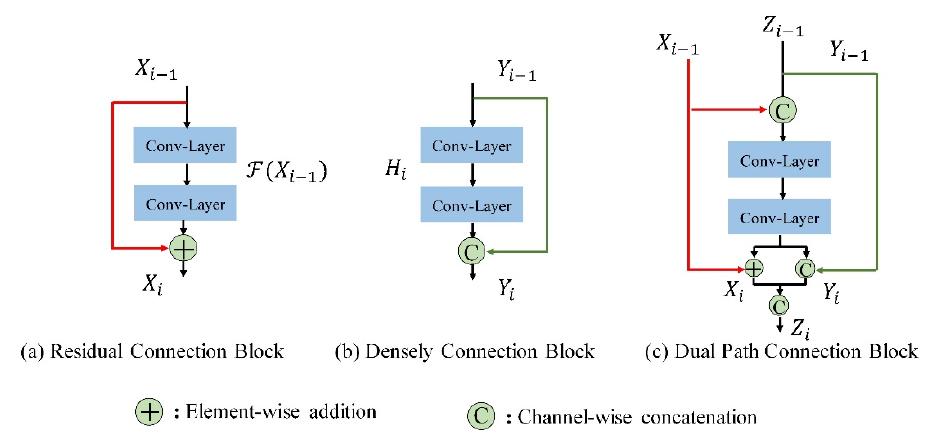
Figure 1. The different feature learning structures: ( a ) Residual Connection Block, ( b ) Densely Connection Block, ( c ) Dual-path Connection Block, where "+" represents element-wise addition, and "C" represents the concatenation operation of feature maps.